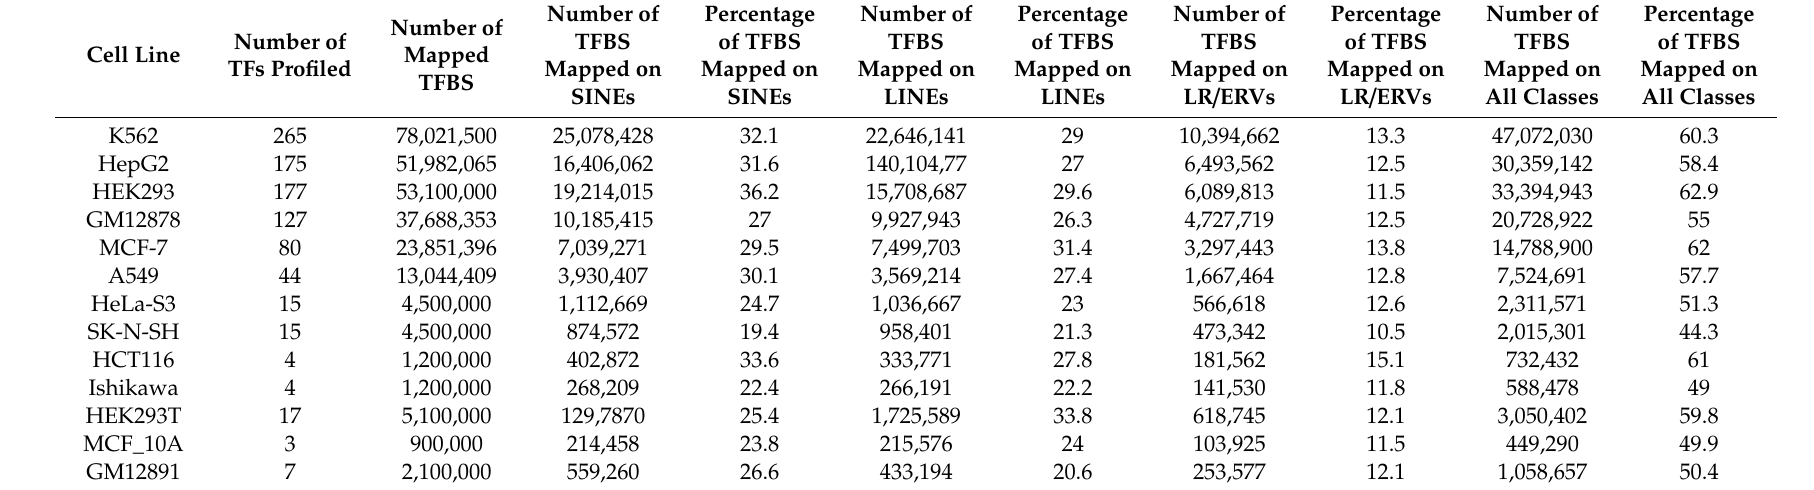
Table 1. Overall transcription factor binding sites (TFBS)